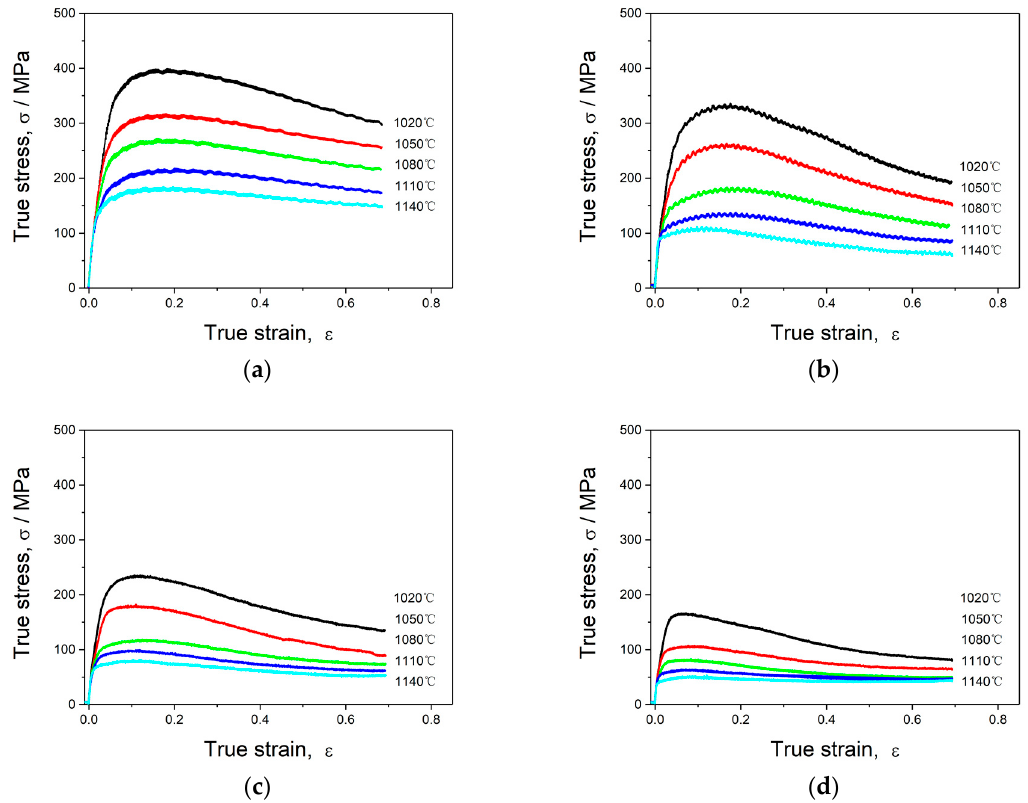
Figure 3. The true stress-strain curves of the PM/Wrought dual superalloy under different deformation temperatures with strain rates of ( a ) 1.0 s − 1 ; ( b ) 0.1 s − 1 ; ( c ) 0.01 s − 1 ; ( d ) 0.001 s − 1 .